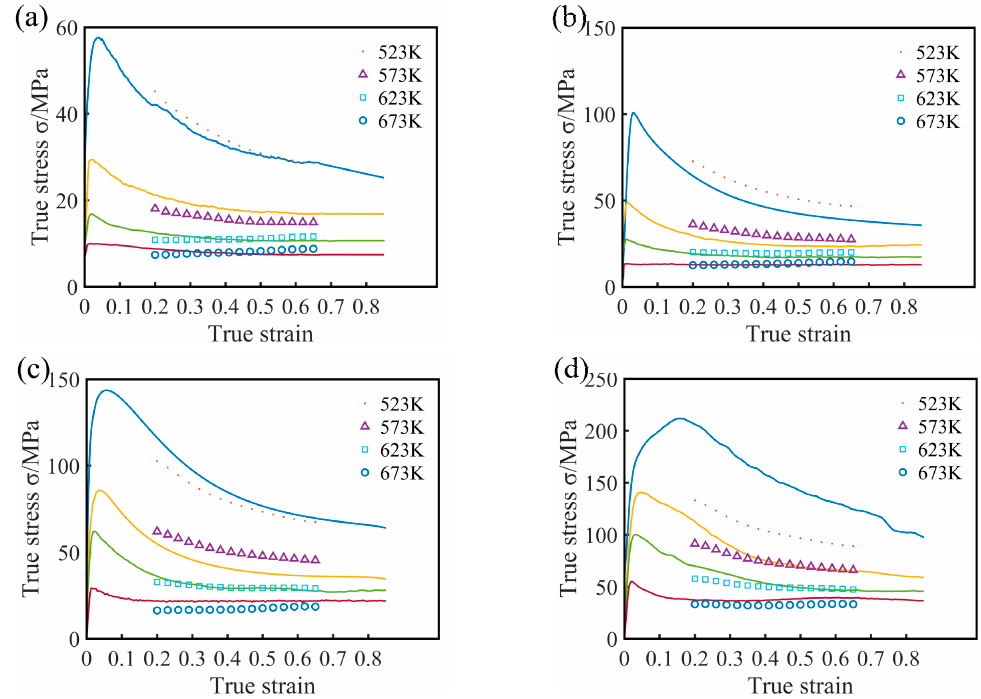
Figure 9. Comparisons between predicted and measured flow stress curves of Mg16Al alloy at different strain rate: ( a ) 0.0001 s − 1 , ( b ) 0.001 s − 1 , ( c ) 0.01 s − 1 , and ( d ) 0.1 s − 1 .